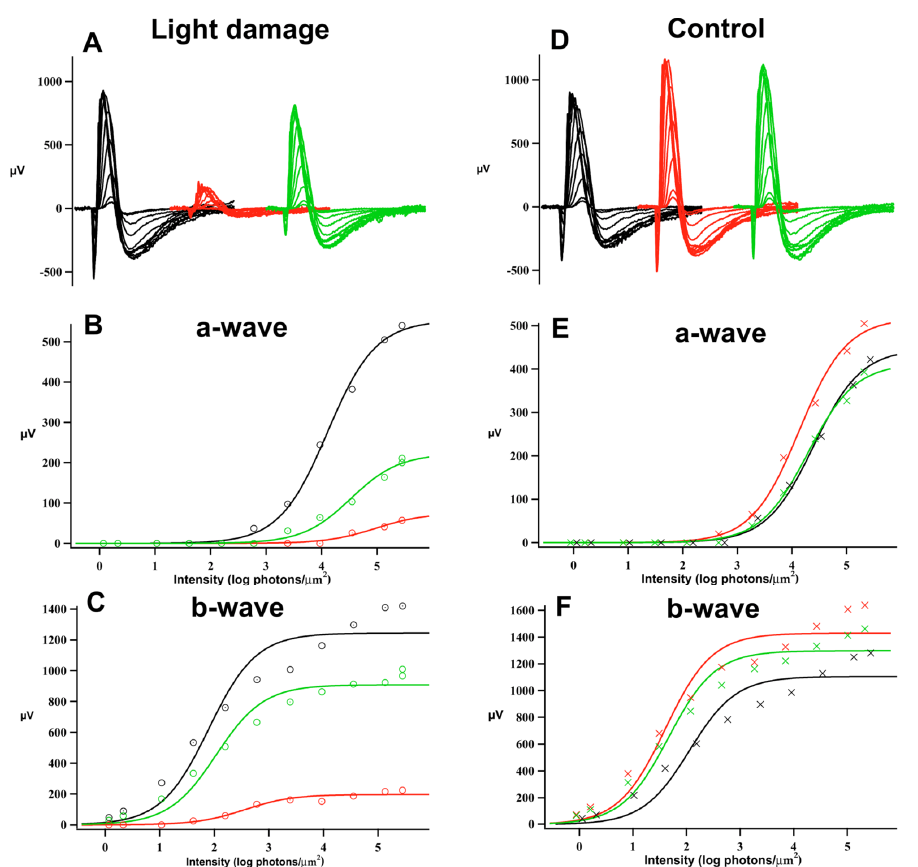
Figure 1. Sample ERG responses and analysis. Functional evaluation of photoreceptor degeneration. ( A ) ERG response families prior to light damage (Pre, black), one day after light damage (R1, red), and 29 days after light damage (R29, green). ( D ) ERG response families prior to sham light damage (Pre, black), one day after sham light damage (C1, red), and 29 days after sham light damage (C29, green). ( B , C ) Intensity ‐ response plots for a–wave and b–wave after light damage. ( E , F ) Intensity ‐ response plots for a ‐ wave and b ‐ wave after sham light damage. The plots were fitted with a modified Michaelis–Menten function (continuous line). Note the significant reduction of a ‐ wave amplitudes and b ‐ wave amplitudes after light damage and the following recovery ( B , C ).